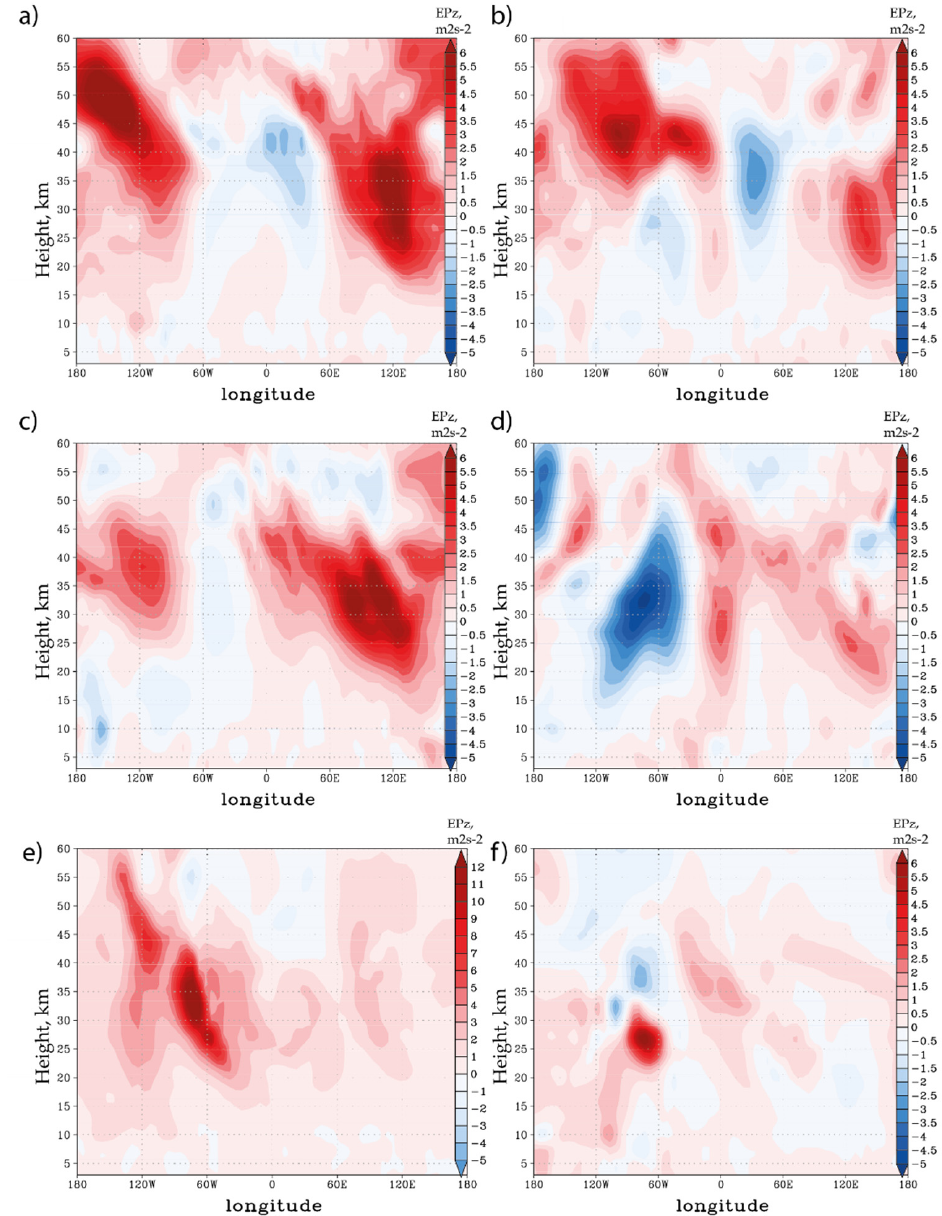
Figure 5. Longitude-height (km) cross section of: ( a ) EPz before SSW on 18 January, 2018; ( b ) EPz before SSW on 20 January, 2018; ( c ) EPz before SSW on 29 January, 2018; ( d ) EPz before SSW on 2 February, 2018; ( e ) EPz during SSW on 11 February, 2018; ( f ) EPz after SSW on 17 February, 2018; averaged at 62.5 °N latitude.